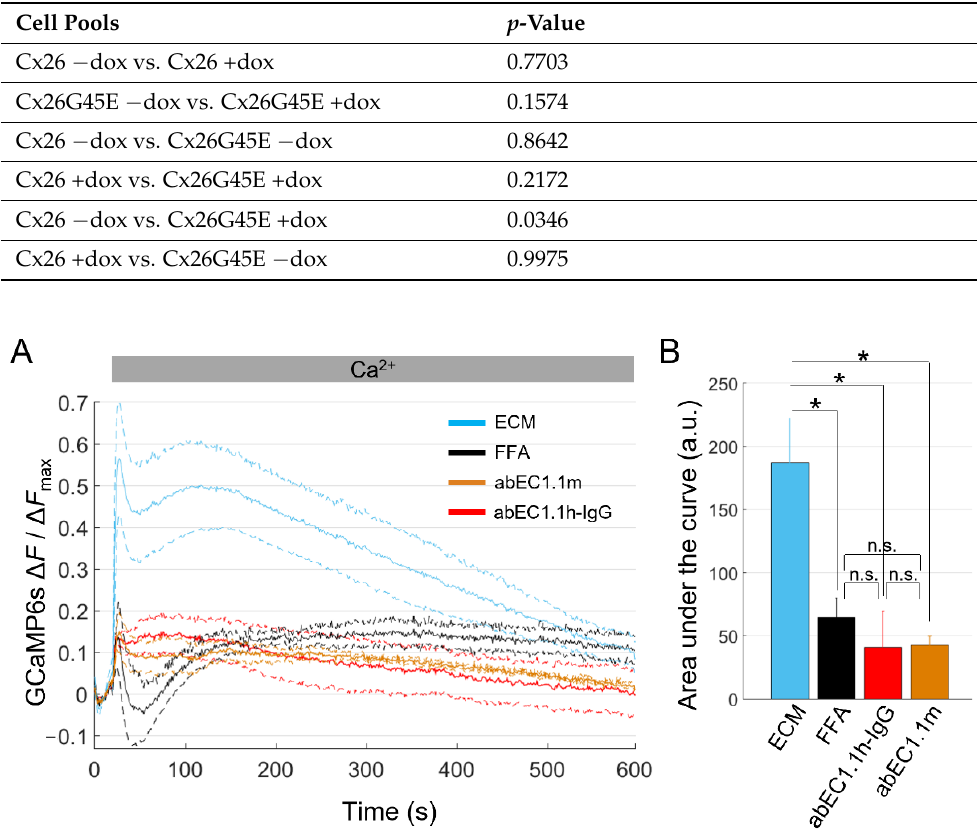
Figure 5. Ca 2+ uptake through leaky Cx26G45E HCs is blocked by antibodies targeting the extracellular domain of Cx26. ( A ) The mean normalized Ca 2+ uptake traces (solid lines) ± s.e.m. (dashed lines) obtained from dox-induced HaCaT-Cx26G45E-GCaMP6s cell cultures maintained in the following extracellular media: ECM (light blue, n = 7), ECM plus FFA (100 µM, black, n = 5), ECM plus abEC1.1h-IgG (1 µM, red, n = 4) or ECM plus abEC1.1m (1 µM, orange, n = 4). ( B ) The mean ±